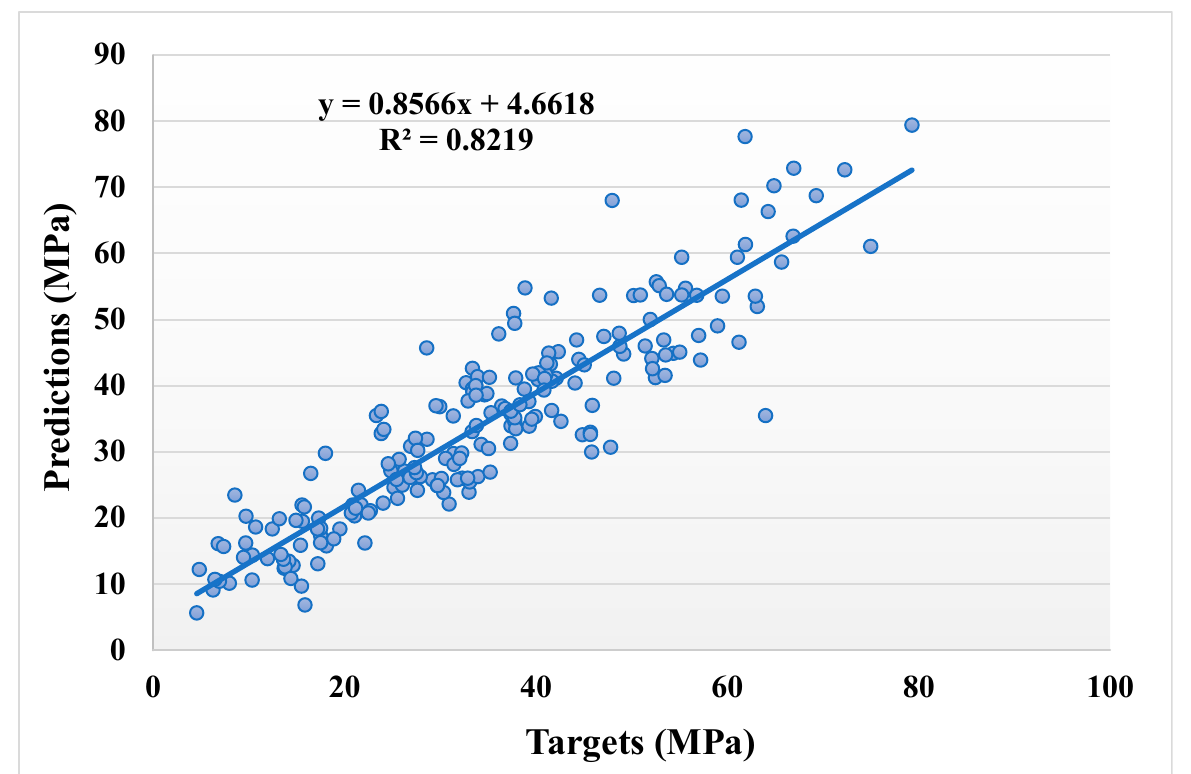
Figure 5. Relationship between the actual and predicted results of the AdaBoost model.